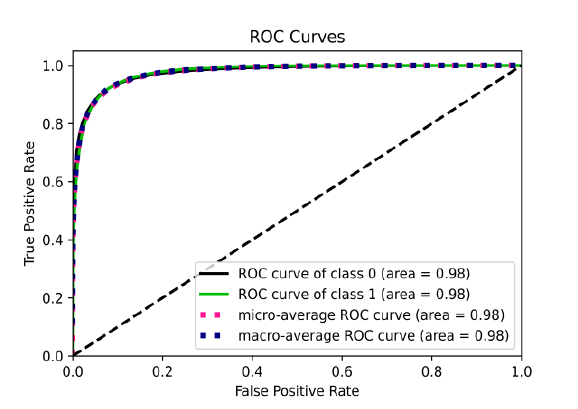
Figure 4. The ROC curve obtained from Model-B.